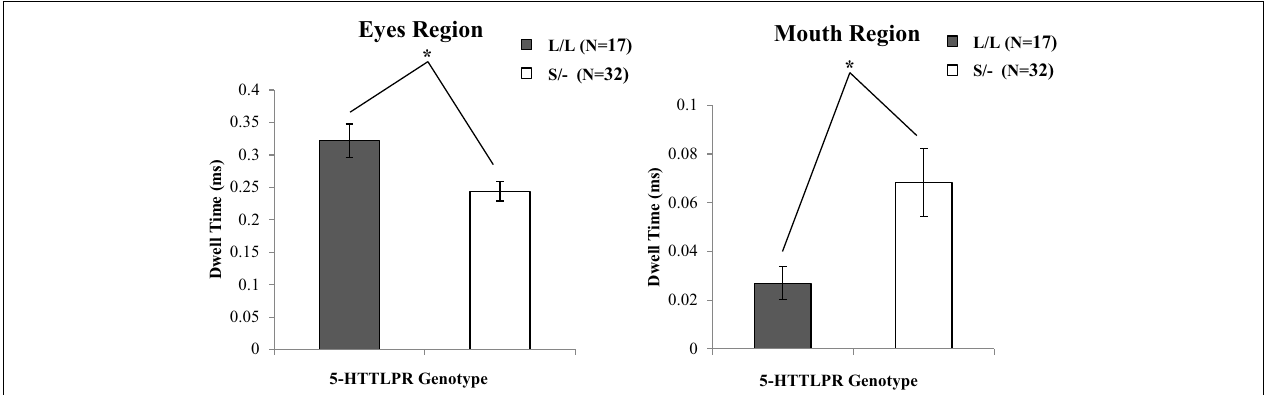
FIGURE 4 | The proportion of time spent among 5-HTTLPR genotype groups looking at the eye and mouth regions relative to the rest of the face during baseline trials . Carriers of at least one Short allele fixated the eye region less, but spent more time looking the mouth region of neutral faces. Error bars denote 1 SEM. * p <